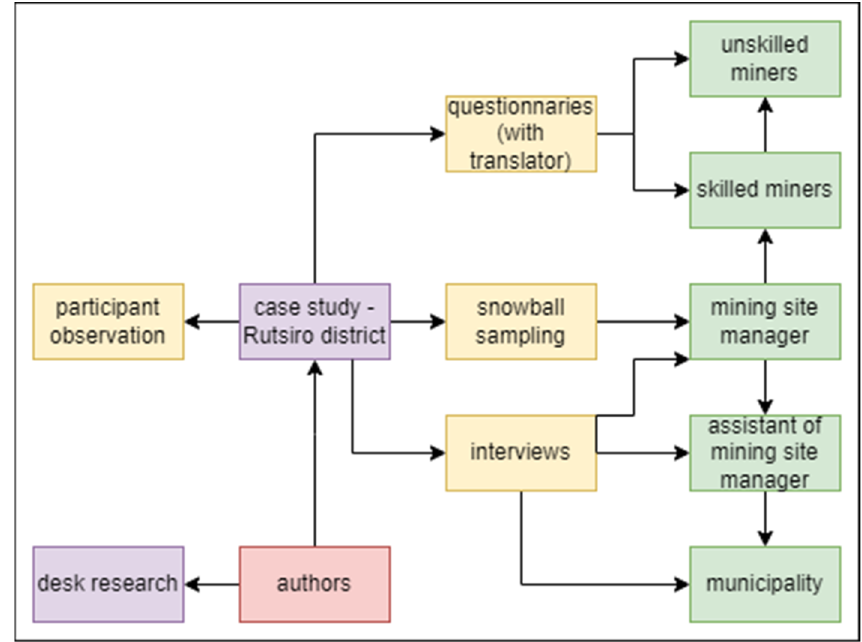
Figure 1. Flow diagram with the steps of the study.